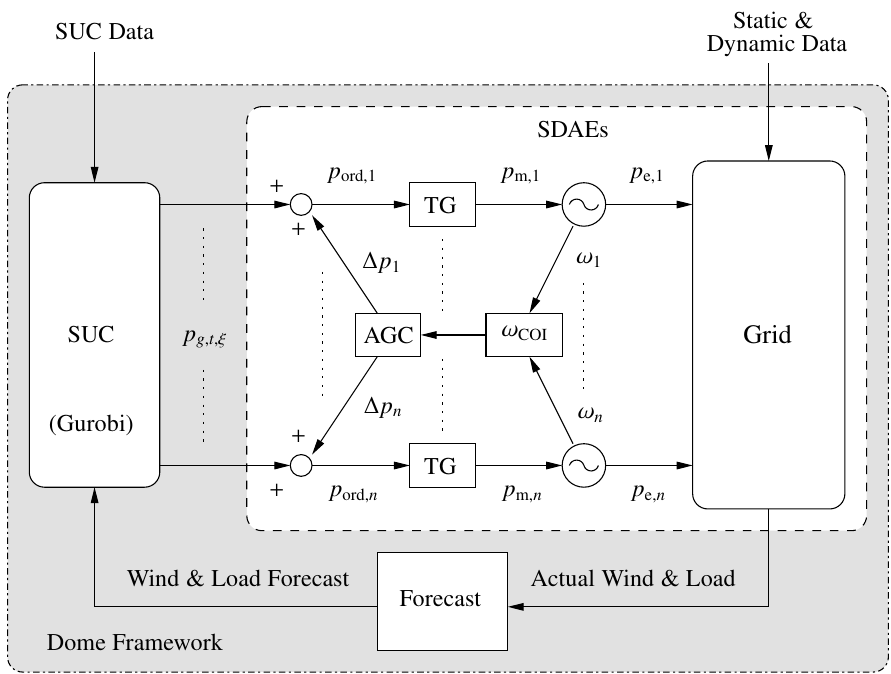
Figure 3. Structure of the interaction between the discrete model of the stochastic unit commitment (SUC) and dynamic model of